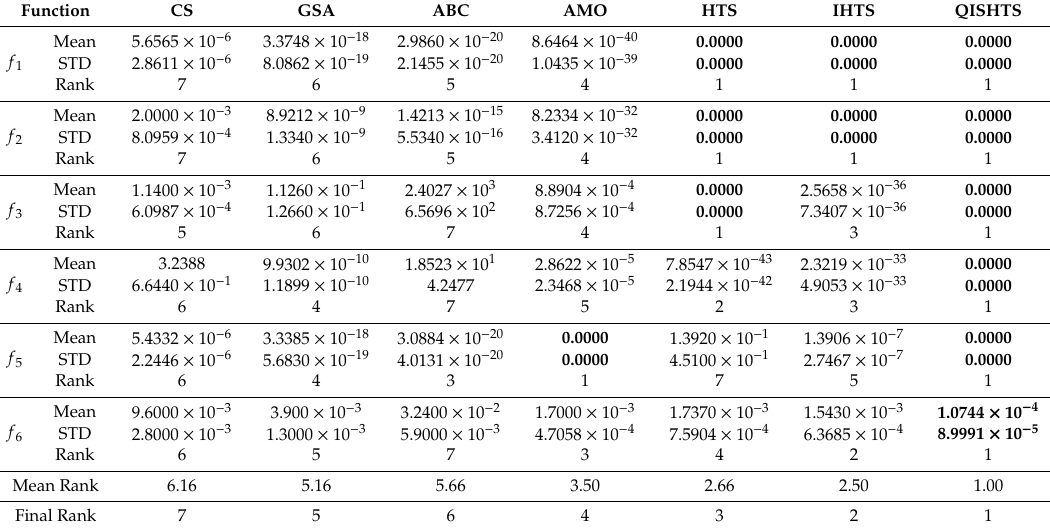
Table 2. Computational results of f 1 – f 6 for the QISHTS algorithm with other meta-heuristic algorithms (MHAs) in Investigation 1. (The results of the competitors are adapted from the literature [44]). CS: cuckoo search, GSA: gravitational search algorithm, AMO: animal migration optimization, ABC: quadratic interpolation based simultaneous heat transfer